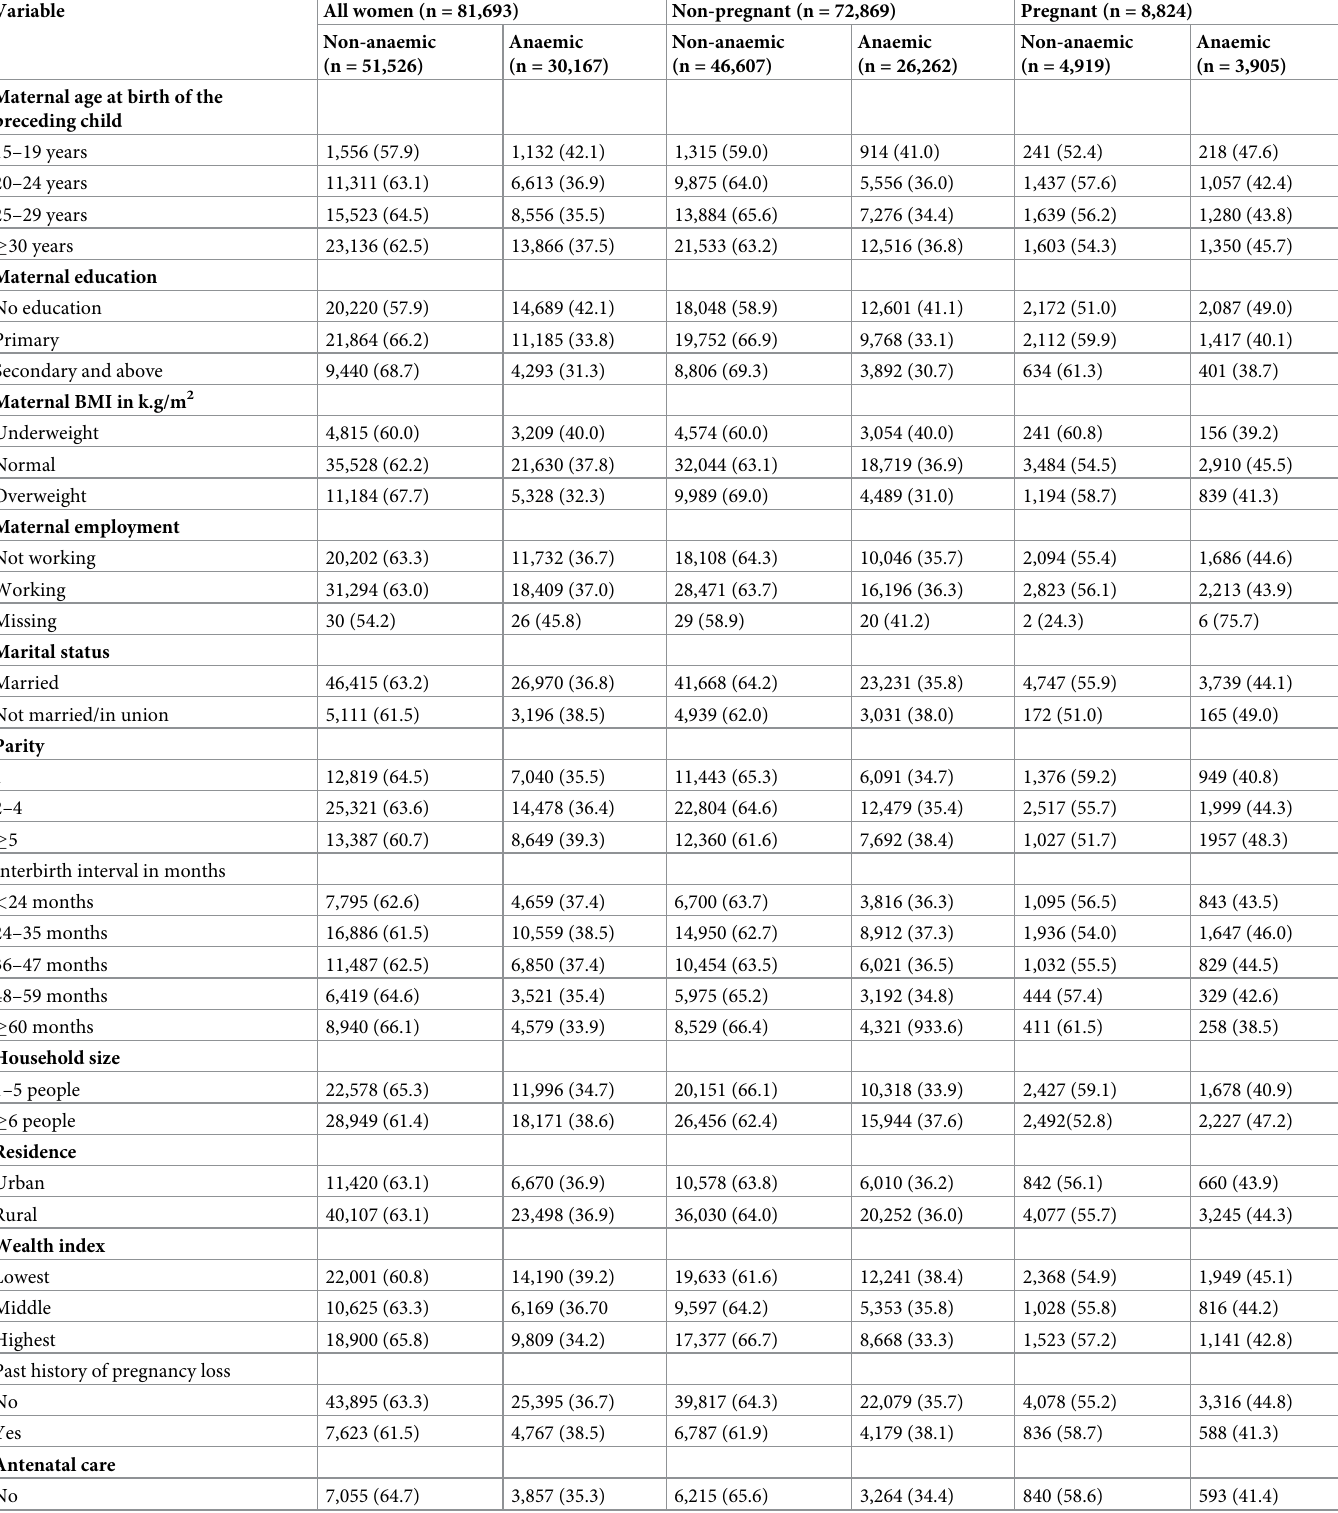
Table 2. The characteristics of the participants in the analysis population by maternal anaemia in sub-Saharan Africa 2010–2017.